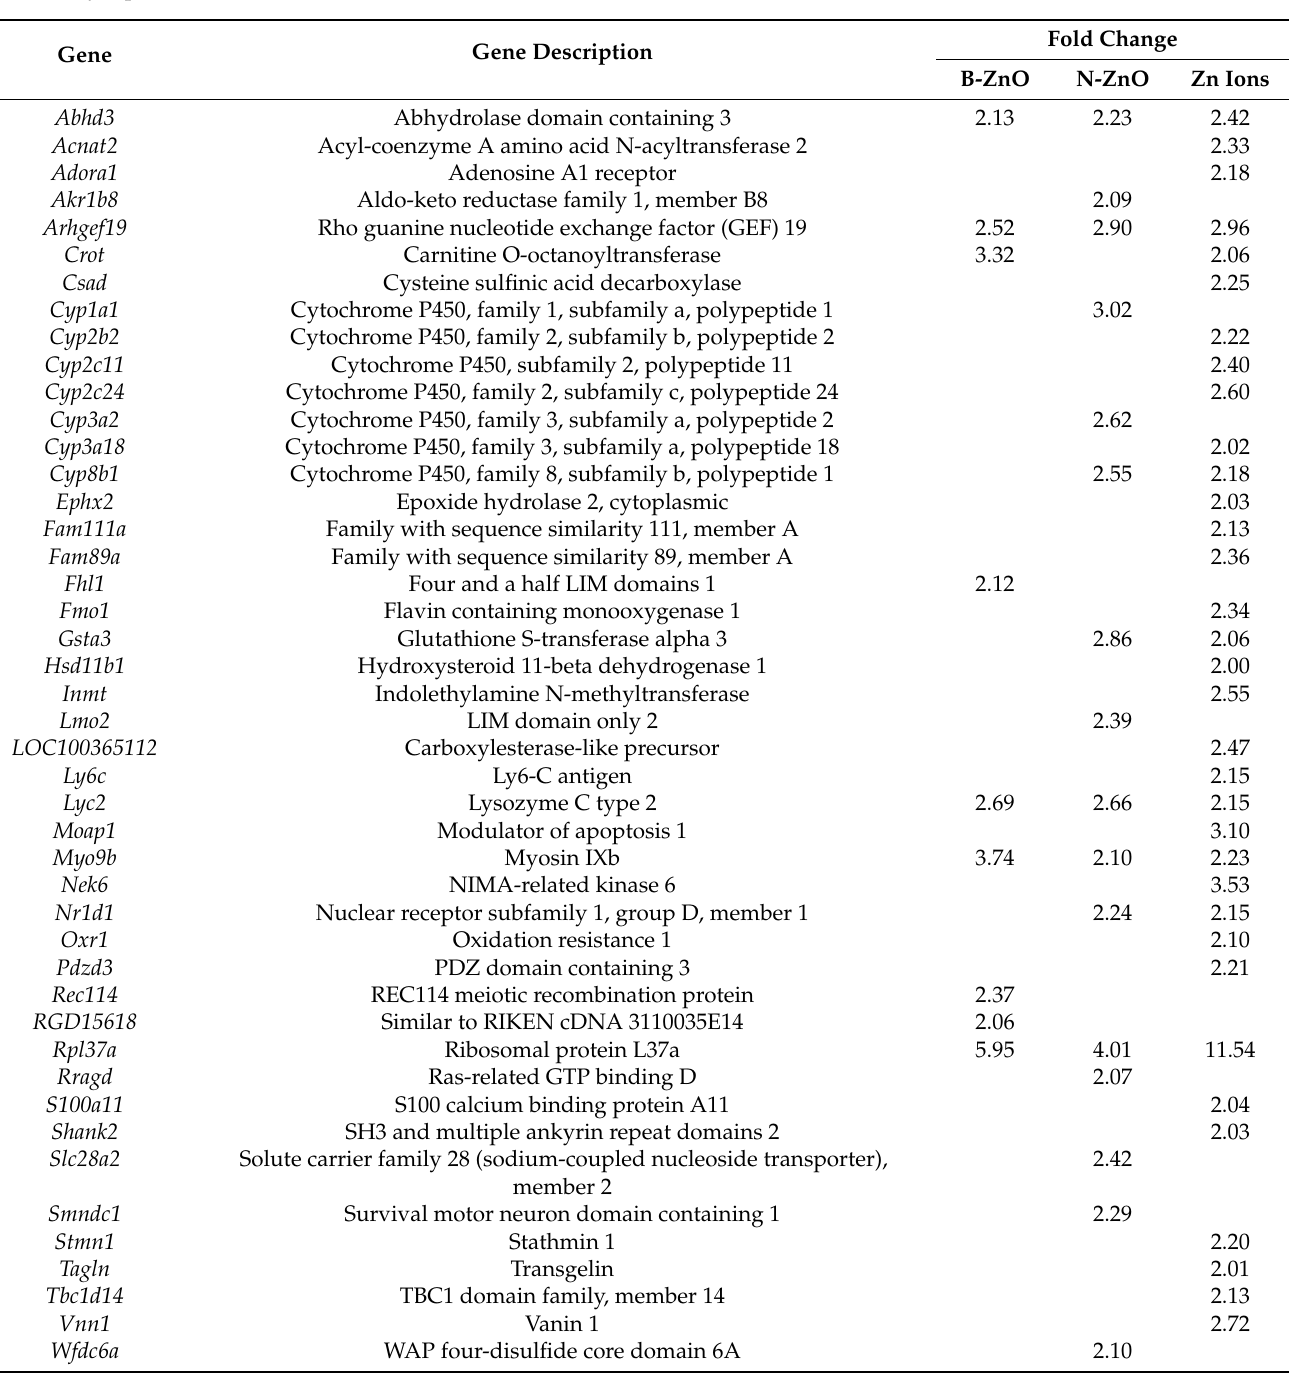
Table 4. Two-fold up-regulated differentially expressed genes (DEGs) compared with non-treated control in the livers after 14-day repeated oral administration of B-ZnO, N-ZnO or Zn ions in rats.